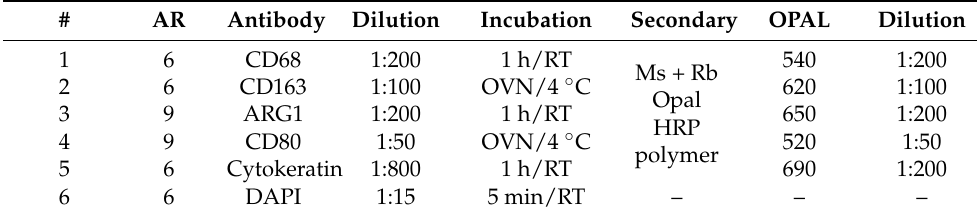
Table 2. Design of the panel for multiplex fluorescent immunohistochemistry (fIHC)